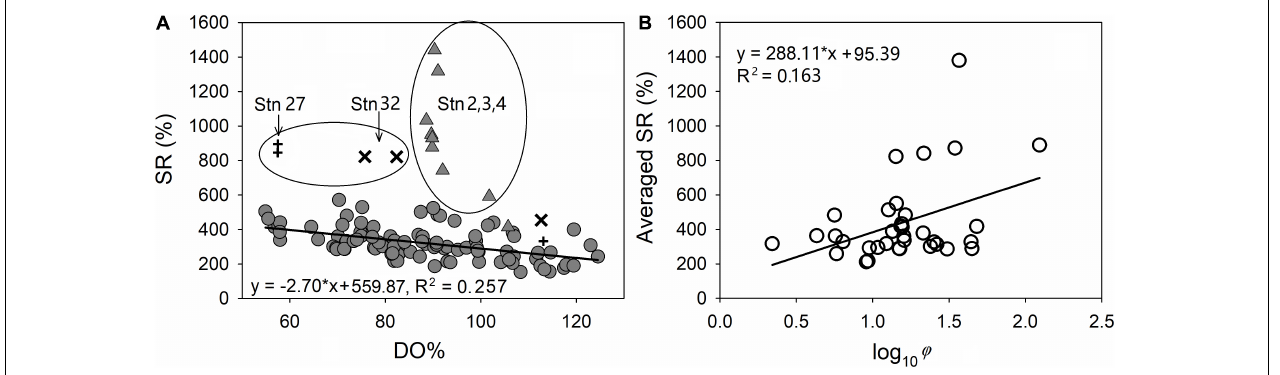
FIGURE 5 | Plots of the saturation ratio of CH 4 (SR) versus DO% at all sampling layers (A) and SR in the bottom layer at each station versus log 10 ϕ (showing the degree of stratification in the water column) (B) . Triangles in an ellipse are subsurface and bottom-water samples from stations 02, 03, and 04, pluses indicate subsurface and bottom-water samples from station 27, crosses indicate subsurface and bottom-water samples from station 32, and filled circles indicate all water samples from other stations.